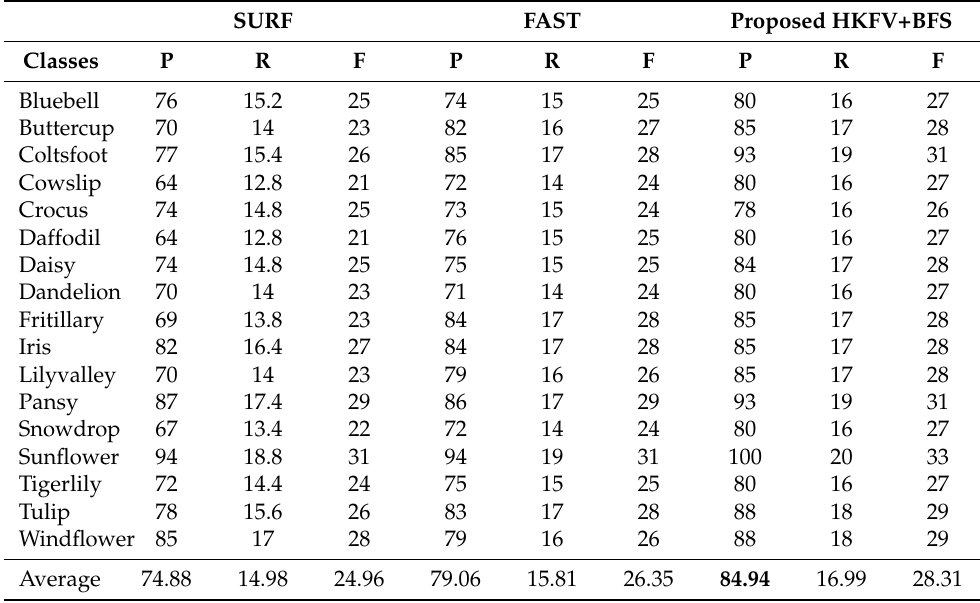
Table 9. HKFV with BFS vs. standalone SURF and FAST on Oxford Flower-17 dataset.